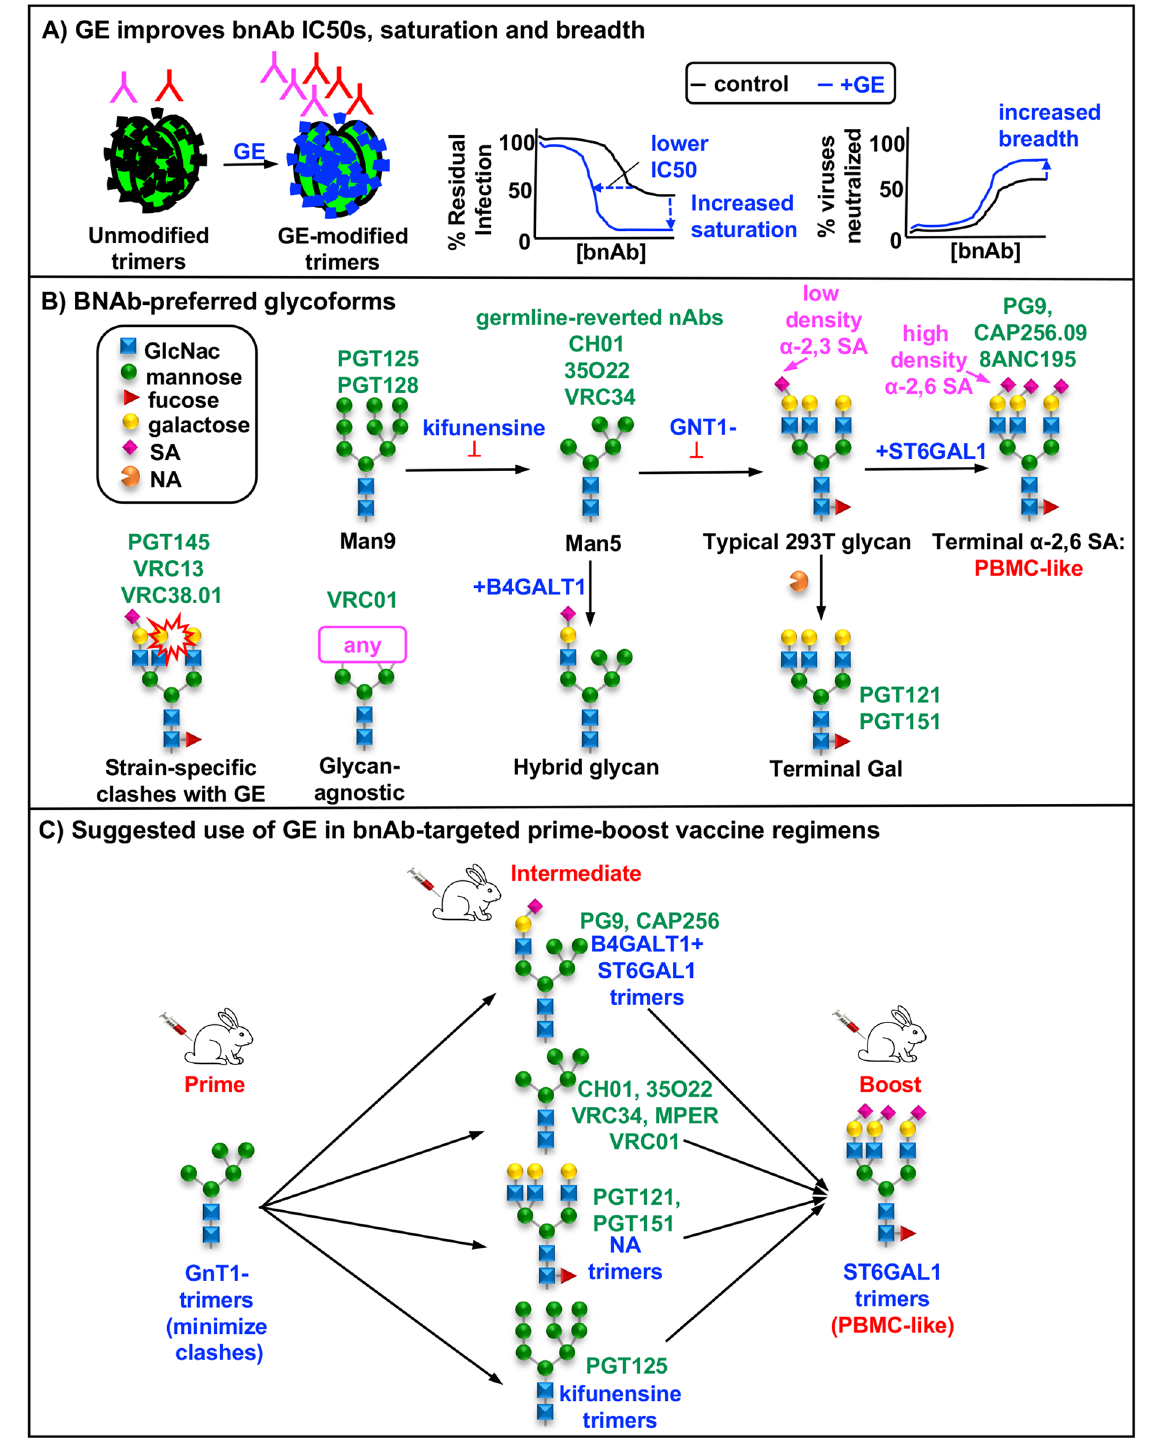
Fig 10. Summary of the effects of GE on bnAb-trimer binding and implications for vaccine development. A) GE increases bnAb sensitivity by lowering IC50 titers, increasing maximum % saturation and increasing breadth. B) The preferred glycoforms of various bnAbs are shown. Preferences include untrimmed high mannose glycans (e.g. PGT125), small glycans (e.g. germline reverted Abs), terminal galactose (e.g. PGT121) and terminal α -2,6 SA (e.g. PG9). Some bnAbs (e.g. VRC01) are largely "glycan agnostic" as they bind protein sites with essentially no glycan clashes that are unaffected by any GE. Other bnAbs (e.g. PGT145) were subject to glycan clashes that